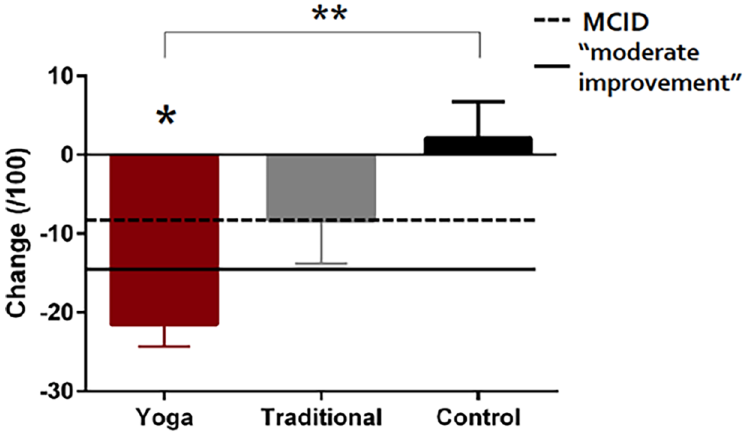
Fig 2. Mean ± standard error change (baseline minus follow-up values) in pain scores of the Knee Osteoarthritis Outcome Score relative to the minimal clinically important difference (MCID) and moderate improvement values. Significant between-group differences are denoted with (cid:3)(cid:3) and within-group change with (cid:3) .